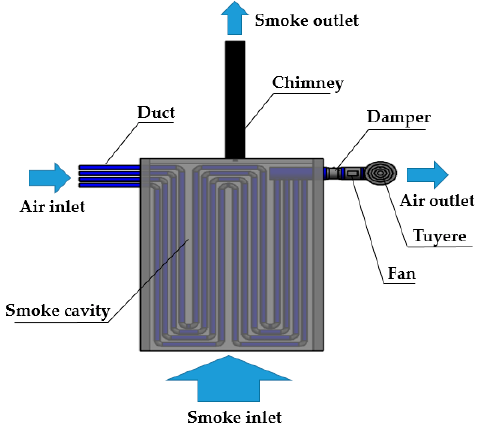
Figure 3. Schematic graph for the pipeline paths of the fresh air system.